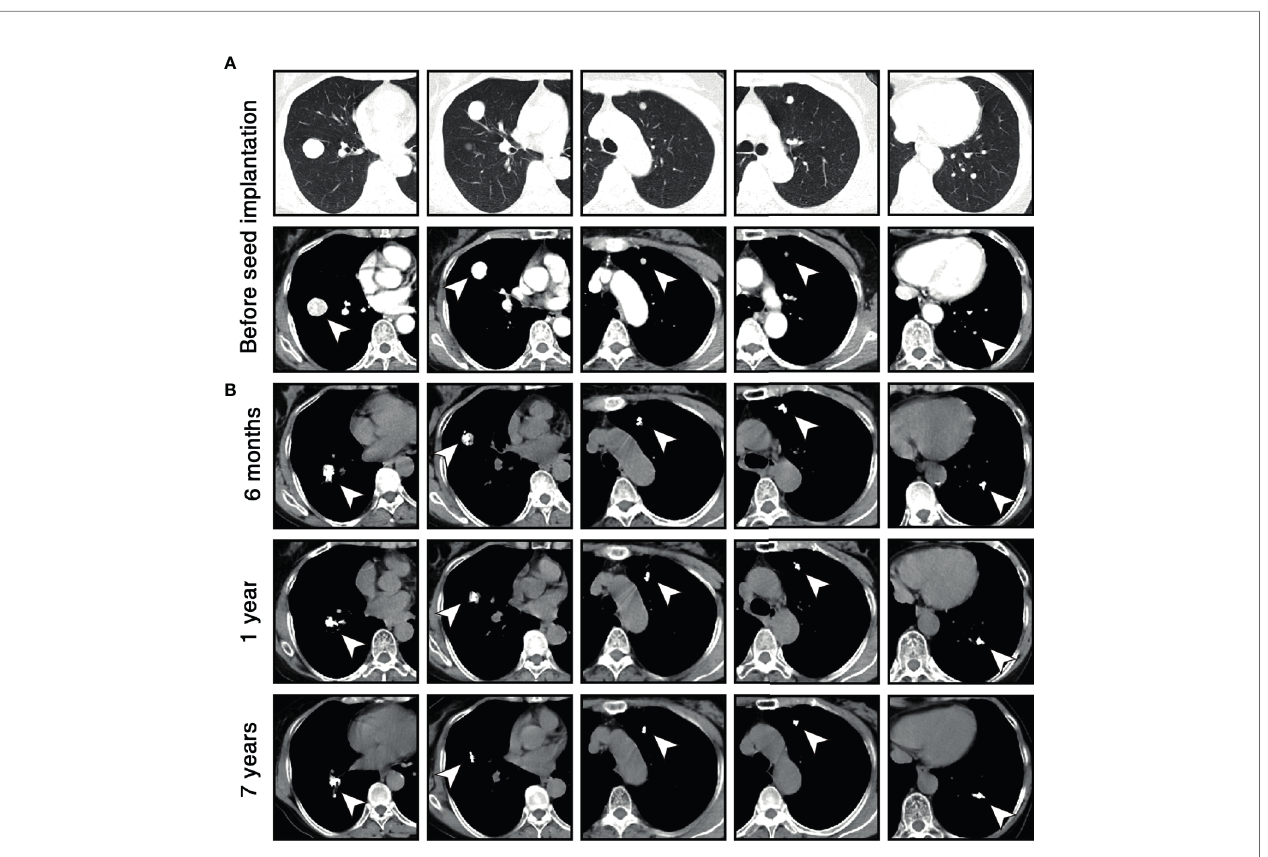
FIGURE 1 | Chest computed tomography (CT) scans of the patient during the follow-up. (A) Before the 125 I seed implantation, contrast-enhanced CT images in lung windows (upper) and mediastinal windows (lower) show 5 enhanced nodules (white arrowheads) in both lungs. (B) Six months, 1 year, and 7 years after 125 I seed implantation, unenhanced CT images in mediastinal windows show that volume of lesions was signi fi cantly reduced within 1 year and remained stable for 7 years. High-density 125 I seeds were located in the original sites of the